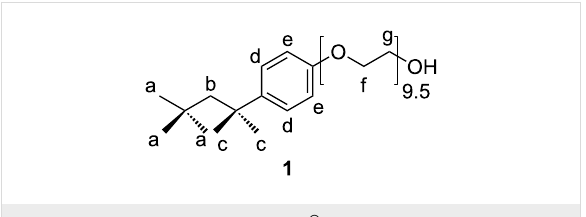
Figure 1: Chemical structure of Triton ® X-100 ( 1